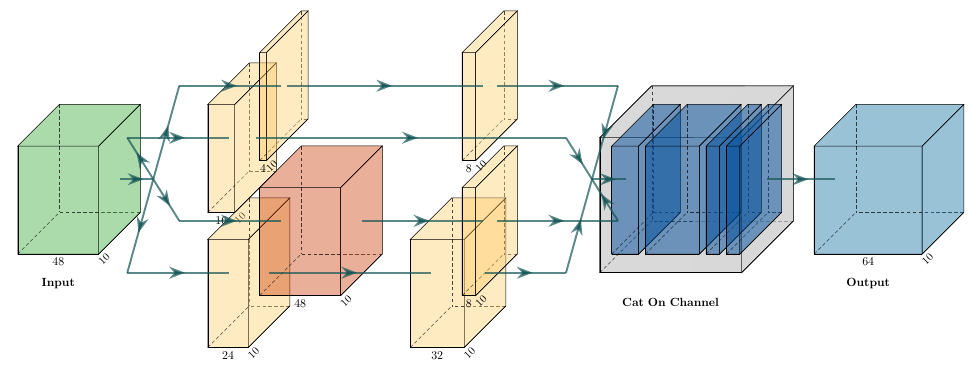
Figure 6. Concrete representation of an inception